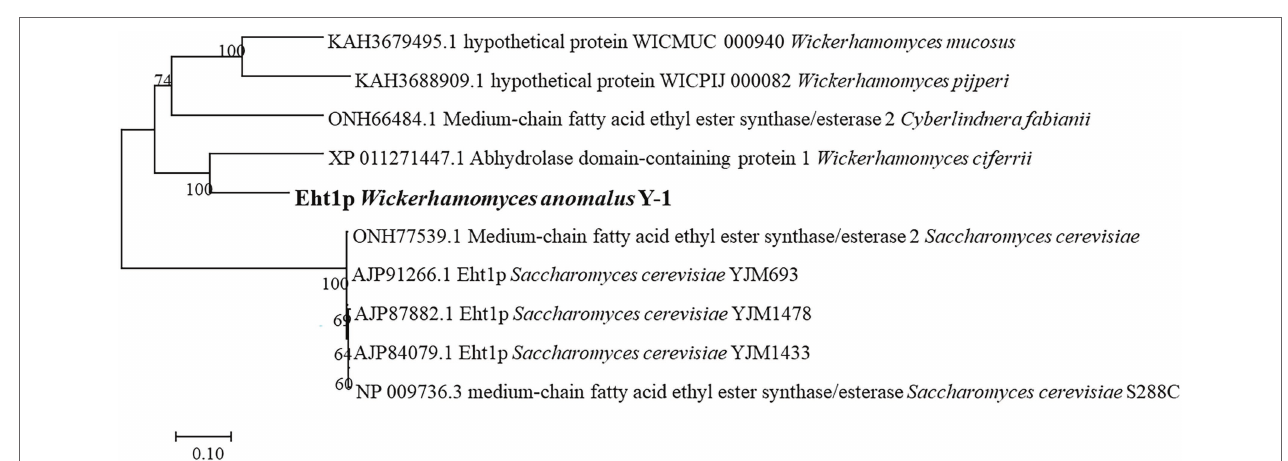
FIGURE 6 | Phylogenetic tree of Eht1p homologous fungi established by